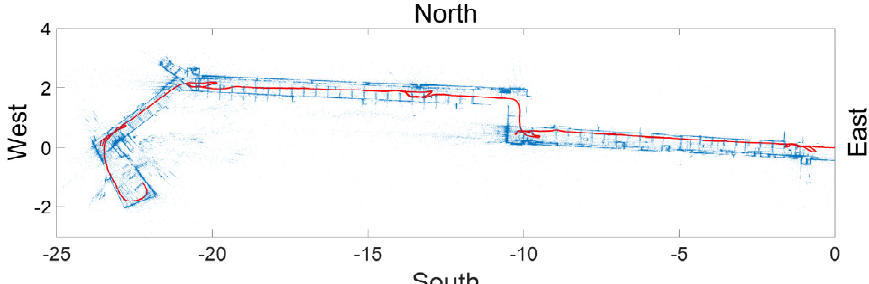
Figure 6. Reconstructed image collection path and a point cloud of the scenes on PathImgs: The points in blue represent the reconstructed point cloud and form a layout of the walls in the corridor. A set of red points passing through the corridor is the locations of PathImgs. The values are represented using a hypothetical unit in the initial reference coordinate system and have no physical scale information.